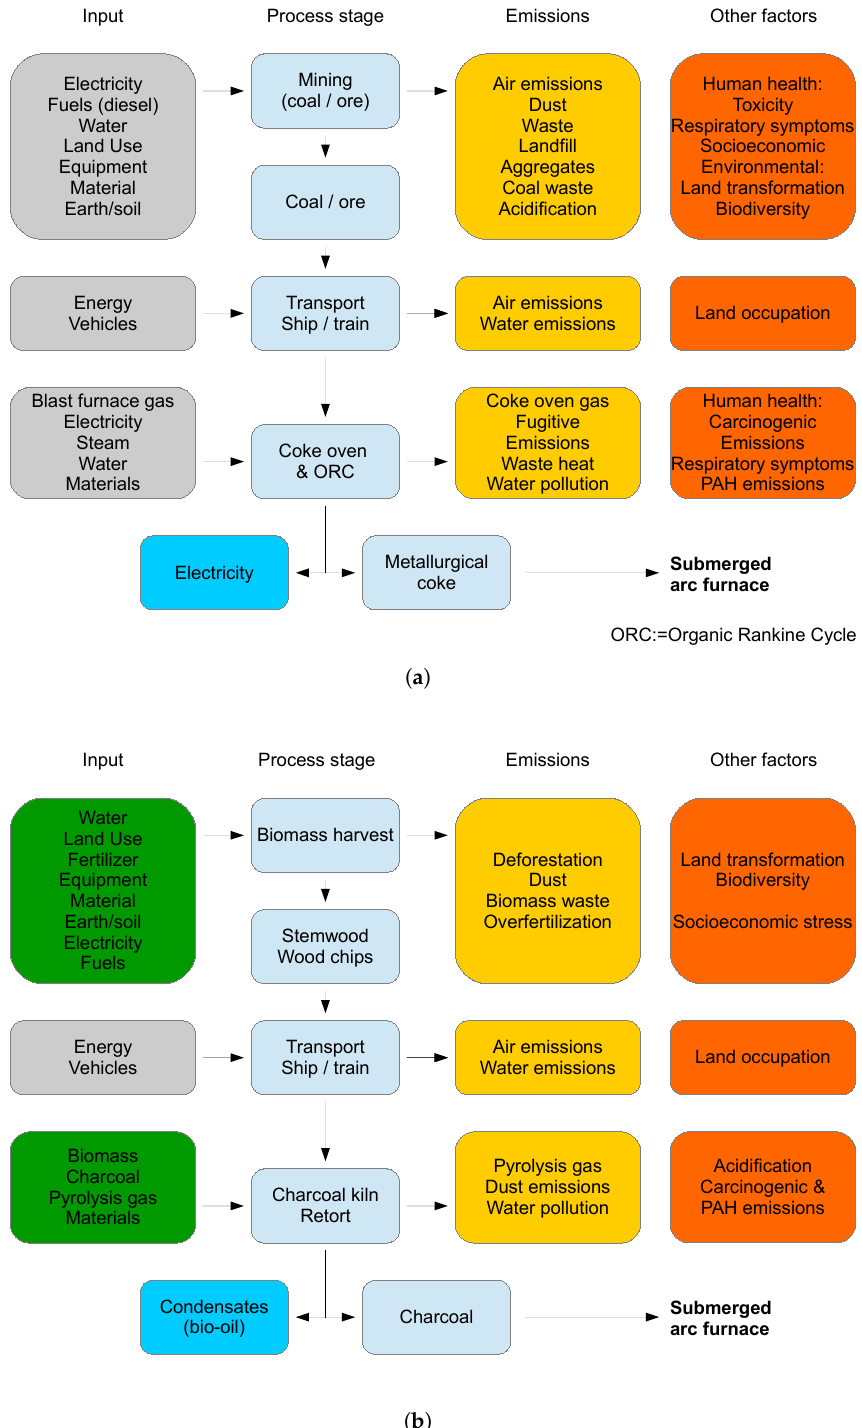
Figure 1. Production route of ferromanganese alloys using ( a ) metallurgical coke or ( b ) charcoal as reductant. Each process step can be accounted as a possible source for greenhouse gas (GHG) emissions. ( a ) Fossil fuel-based reductant. ( b ) Renewable